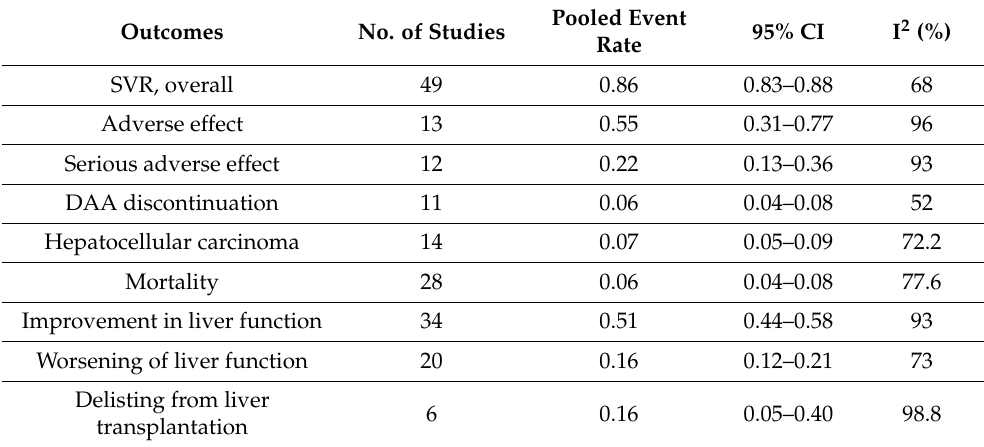
Table 3. Summary of outcomes for patients with decompensated cirrhosis infected with hepatitis C virus (HCV)